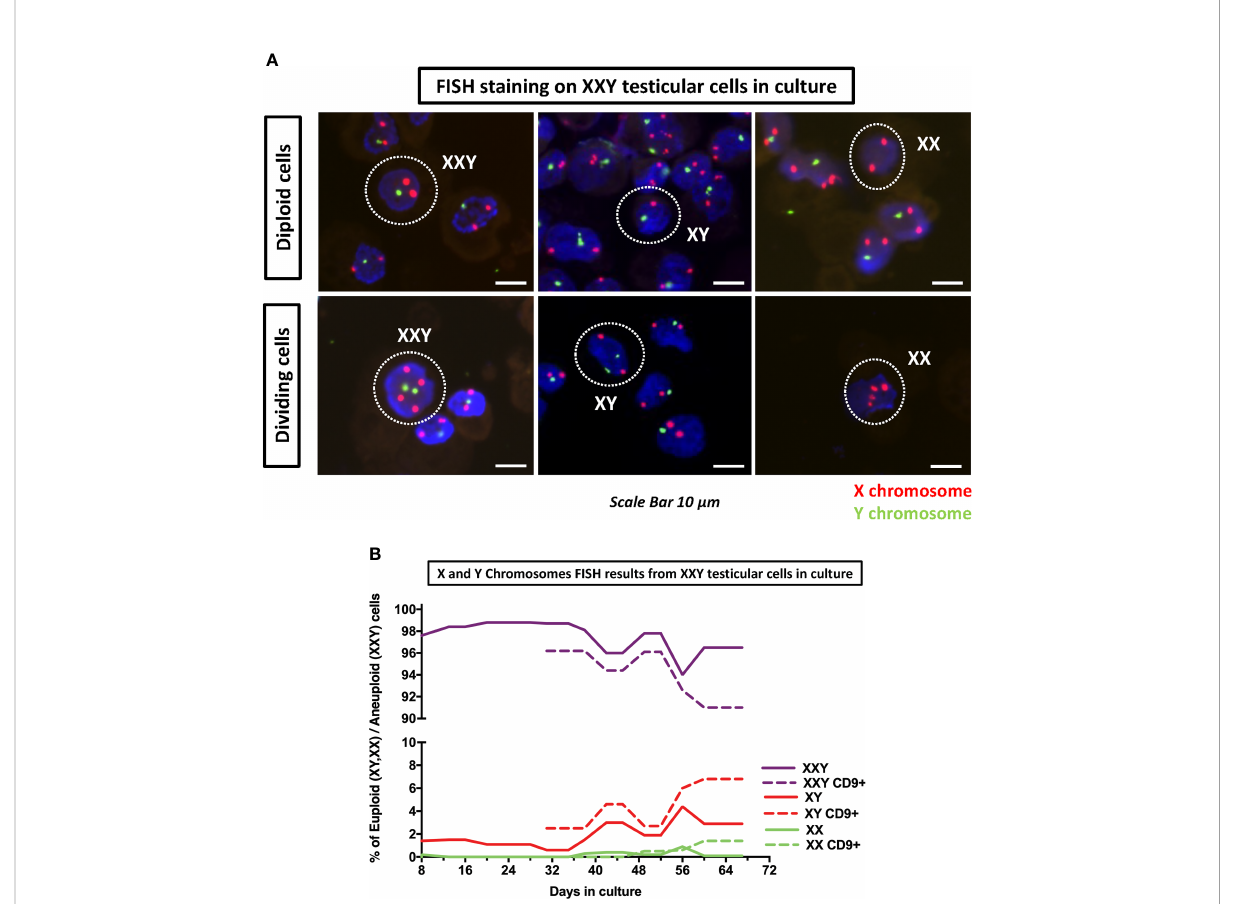
FIGURE 9 DNA FISH analyses of cultured cells was used to assess the number of copies of X (red probe) and Y (green probe) chromosomes on KS testicular cells in culture. (A) Detection of XXY, XY and XX in culture as well as their respective dividing counterparts. (B) Quanti fi cation of XXY, XY and XX populations in consecutive passages during the culture. The results showed a consistent mosaic population (solid lines). Moreover, when cells in culture were enriched for undifferentiated spermatogonia marker CD9+ using MACS, both XY and XX population increased (dot lines) suggesting that higher number of euploid cells in spermatogonia